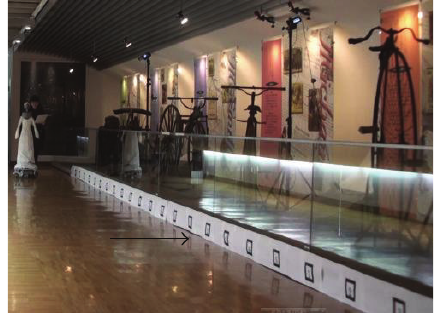
Figure 7: ARToolkit markers that can be spotted by the robot’s on- board web